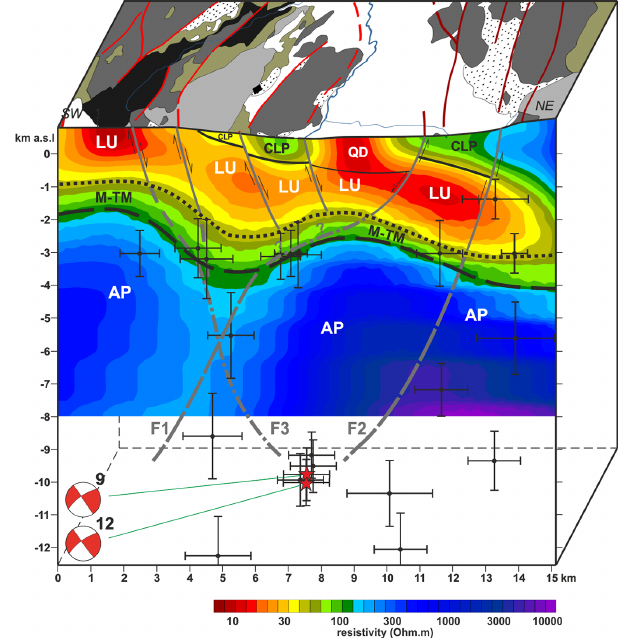
Figure 7. MT model compared with morphostructural map of the Agri Valley and projection along the MT model of seismicity. The focal mechanisms of the two events represented with red stars dis- play normal-faulting kinematics on two possible NW–SE trending fault plane solutions, which are compatible to either F2 or